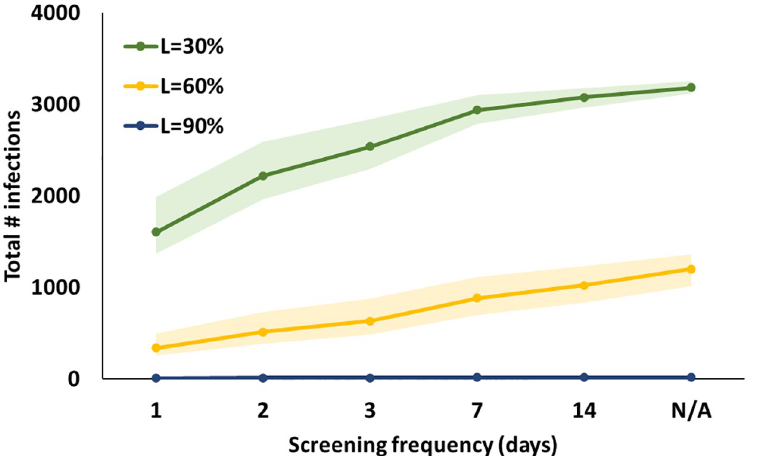
Fig 3. Total number of infections versus screening frequency for three levels of initial vaccine coverage, indicated by color, for a 60/day vaccination rate and 75% compliance ( η = α = 75%) in the base-case scenario with full screening. Each shaded region depicts the uncertainty region resulting from varying levels of screening and vaccination compliance (60%, 75%, 90%), test sensitivity (70%, 80%) and specificity (98%, 99.7%). N/A represents “no screening.” (Note: The shaded region of the blue line is extremely narrow for the scale